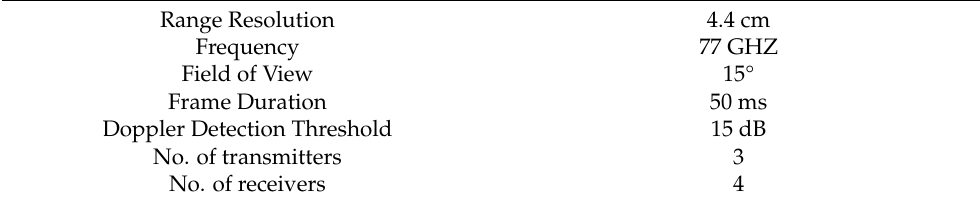
Table 1. Main configuration of Texas instruments AWR1843-BOOST